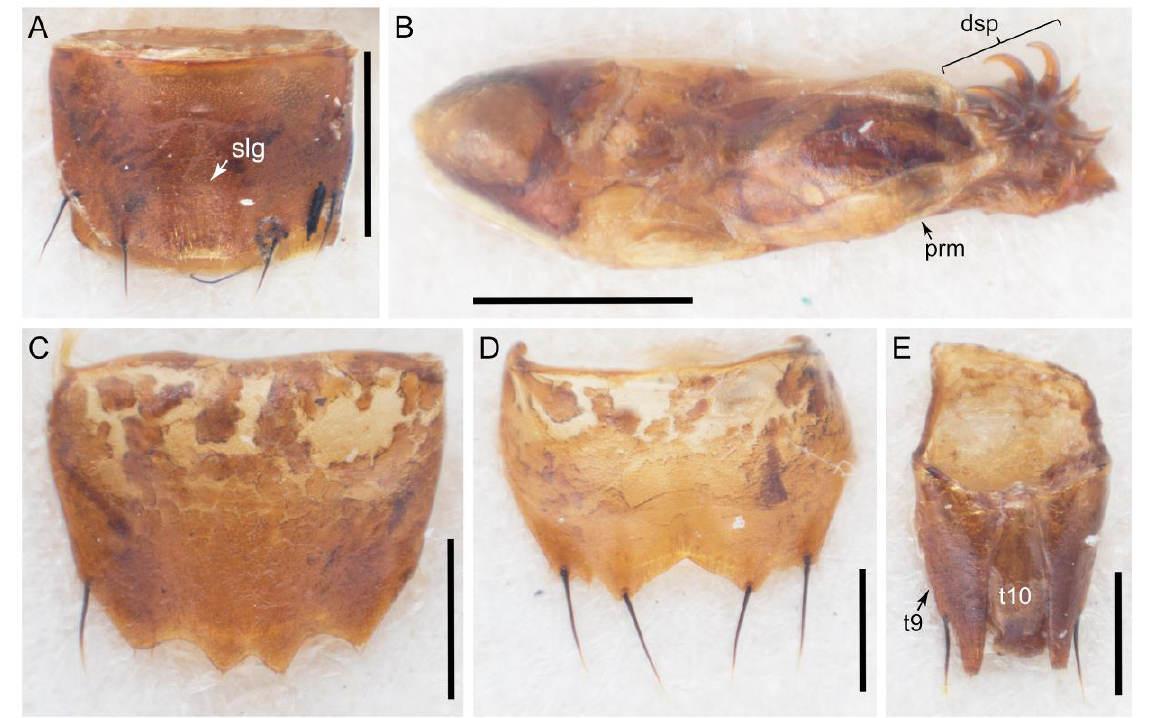
Figure 42. Photographs of Vatesini ( Tachinoproporus ferrugineus , syntype, male). ( A ) sternite VII, ventral view. ( B ) aedeagus, ventral view. ( C ) tergite VIII, dorsal view. ( D ) sternite VIII, ventral view. ( E ) tergites IX–X, dorsal view. Scale bars: 0.5 mm ( A ); 0.3 mm ( B – E ). Abbreviations: dsp, developed short spines; prm, paramere; slg, shallow longitudinal groove on the sternite VII; t9–10, tergite